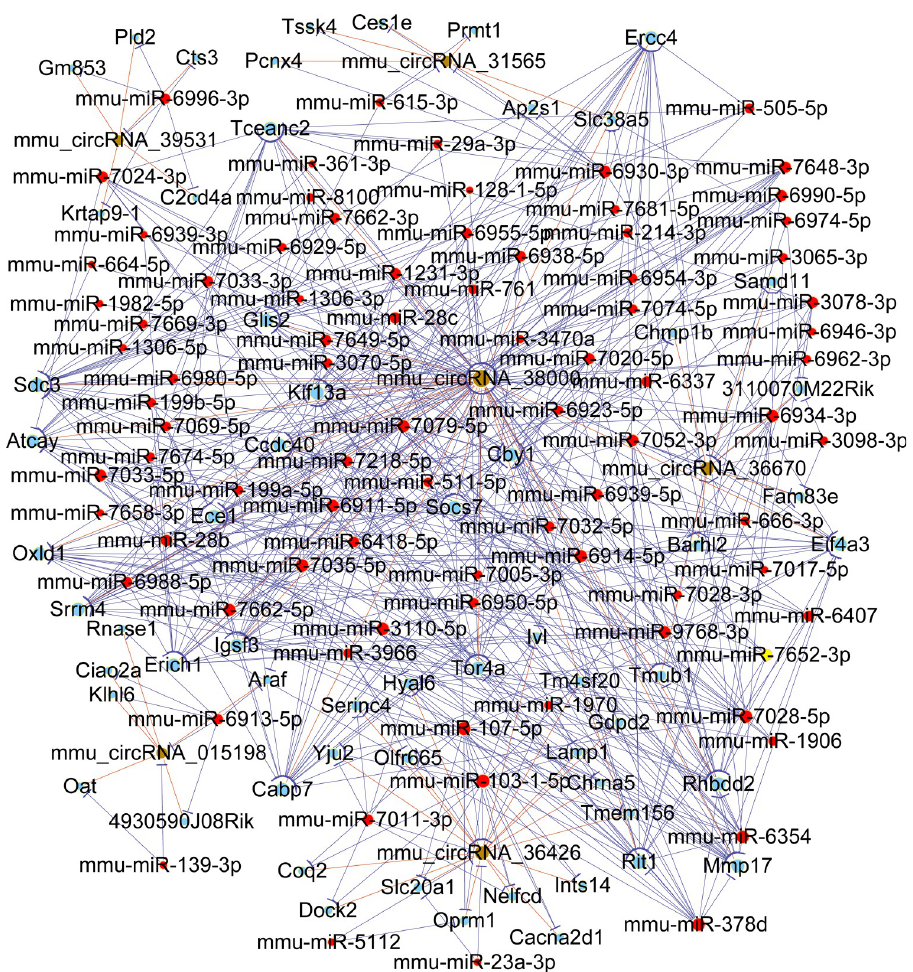
Fig 6. Functional analysis of validated circRNAs. (A) GO enrichment analysis of the upregulated circRNA parental genes. The Y axis represents log 10 (P value). The X axis indicates the top 10 GO terms corresponding to the upregulated circRNAs. (B) GO enrichment analysis of the downregulated circRNA parental genes. The Y axis represents log 10 (P value). The X axis indicates the top 10 GO terms corresponding to the upregulated circRNAs. (C) The top 10 Pathways of upregulated circRNAs are presented. (D) The top 10 Pathways of downregulated circRNAs are presented.